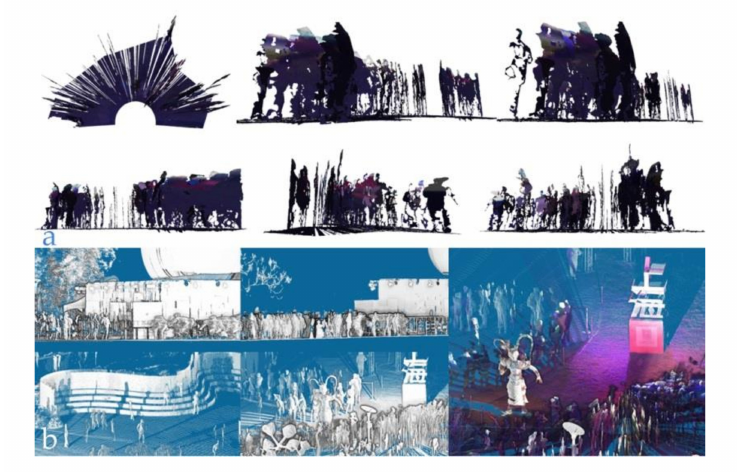
Figure 5. ( a ) The crowd appeared as multiple moving trails in radical shape around the scanner; ( b ) grouping